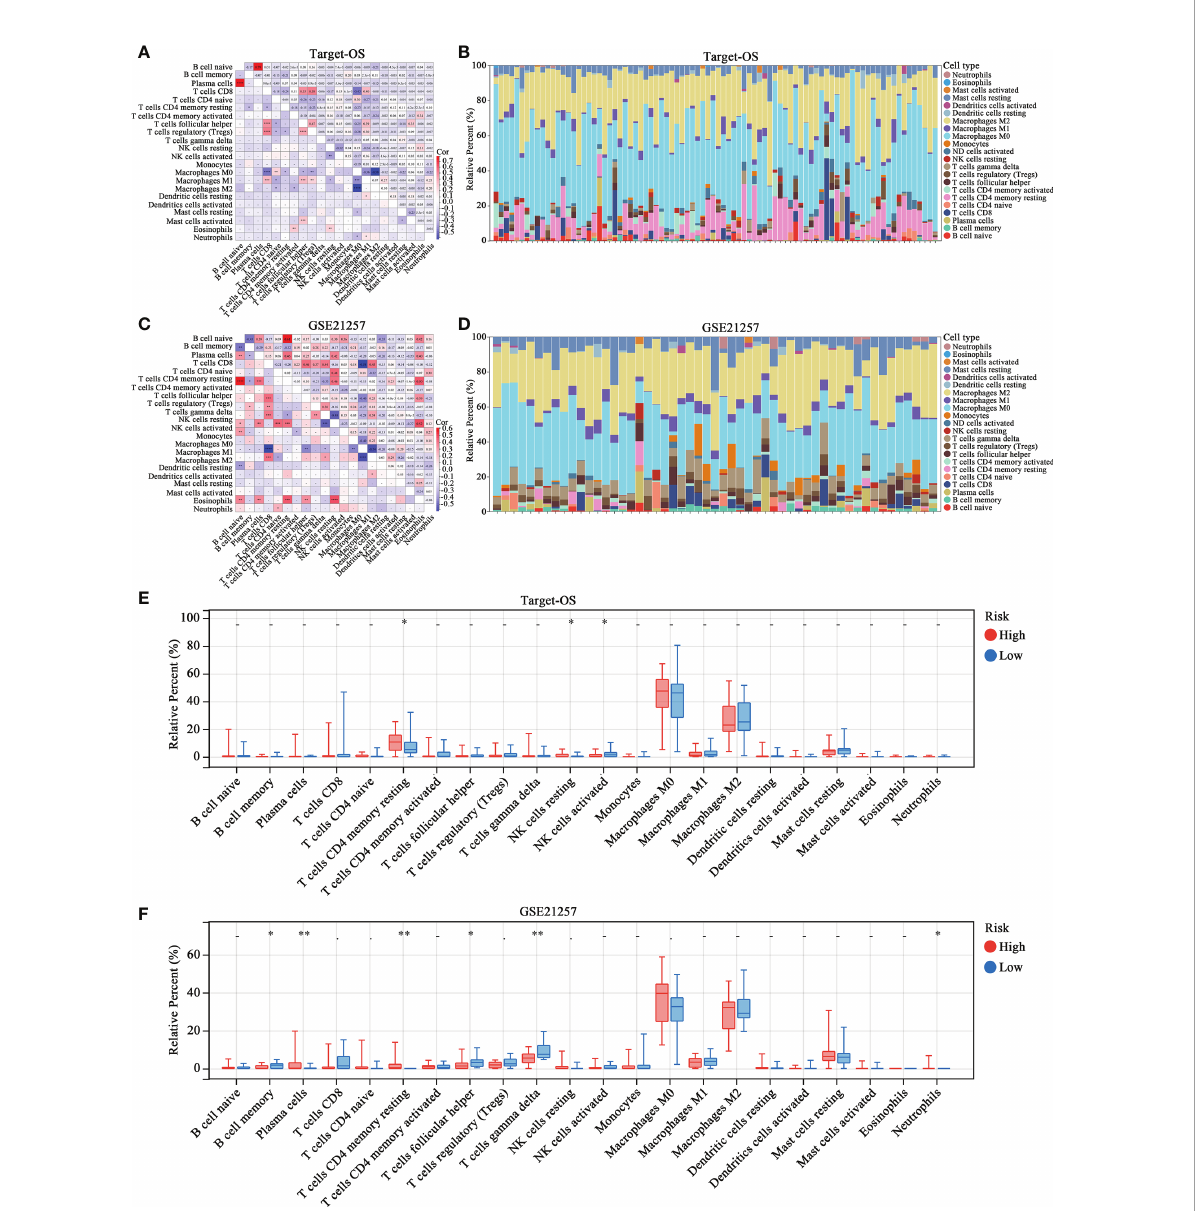
FIGURE 4 The landscape of immune cell in fi ltration in high- and low-risk OS patients. (A – D) Correlation matrix and relative proportion of all 22 immune in fi ltration cell proportions based on CIBERSORT in the Target-OS (A, B) and GSE21257 (C, D) cohorts. (E, F) Boxplots visualize the differences of all 22 immune cells between the high- and low-risk groups. “ * ” represents P<0.05 and “ ** ” represents